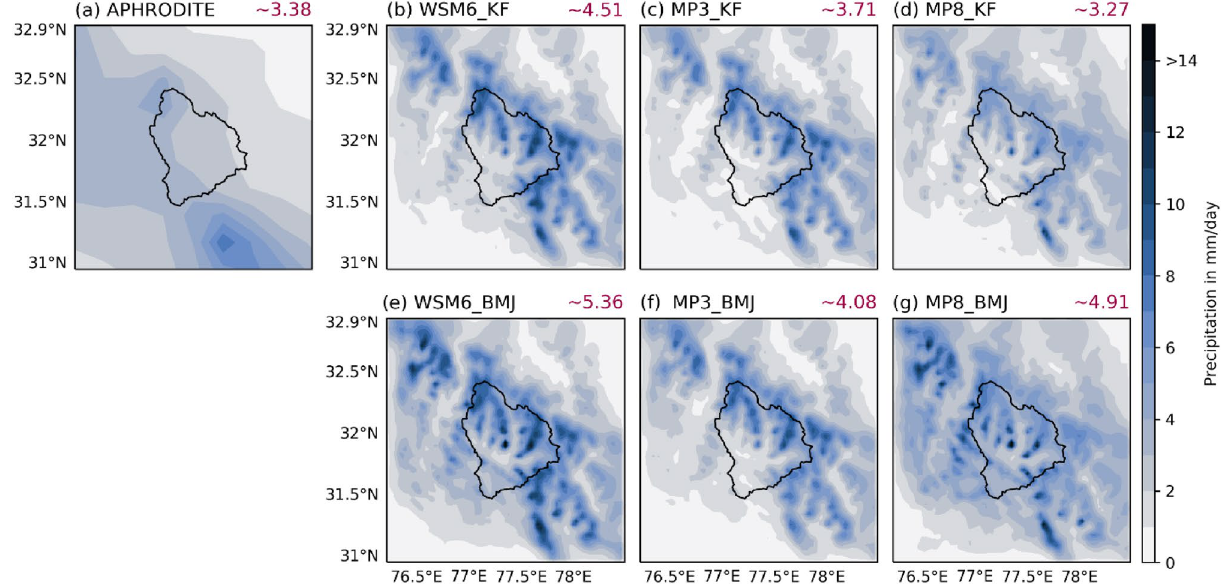
Figure 4. ( a ) Annual mean observed precipitation from APHRODITE. WRF simulated annual mean precipitation over d03 during 2003: ( b ) WSM6_KF, ( c ) MP3_KF, ( d ) MP8_KF, ( e ) WSM6_BMJ, ( f ) MP3_BMJ, and ( g ) MP8_BMJ. The red color numbers at the right top corner is the areal-temporal average precipitation in